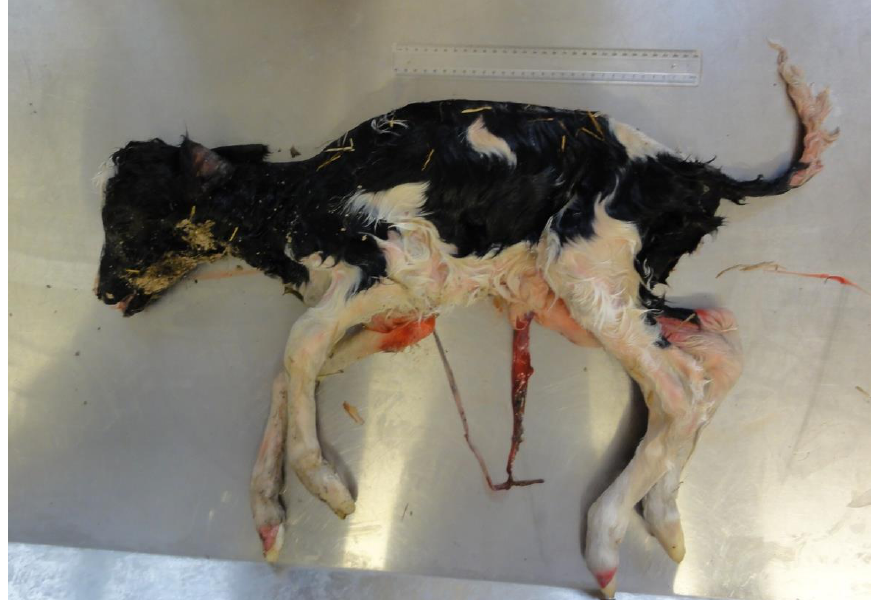
Figure 1. Intra-uterine growth retardation (IUGR) may be a sub-lethal or lethal consequence of an infection in utero (in this case, Leptospira hardjo , 261-day gestation, 7.8 kg). Note: ruler length 30